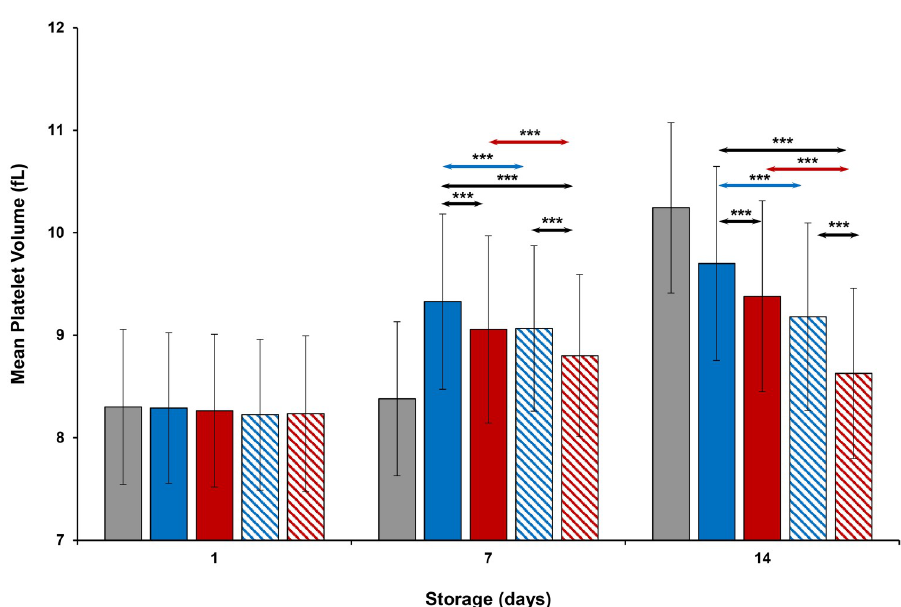
Fig 2. Effects of 14-day storage, temperature and presence of p38MAPK inhibitor on platelet mean volume. Grey bar–platelets stored at room temperature; blue solid bar–cold-stored platelets; red solid bar–thermocycled-stored platelets; blue striped bar–cold-stored + VX-702 platelets; red striped bar–thermocycled-stored + VX-702 platelets. Data represents the mean of 15 experiments with one standard deviation. Arrows represent paired statistical differences; ��� —p <